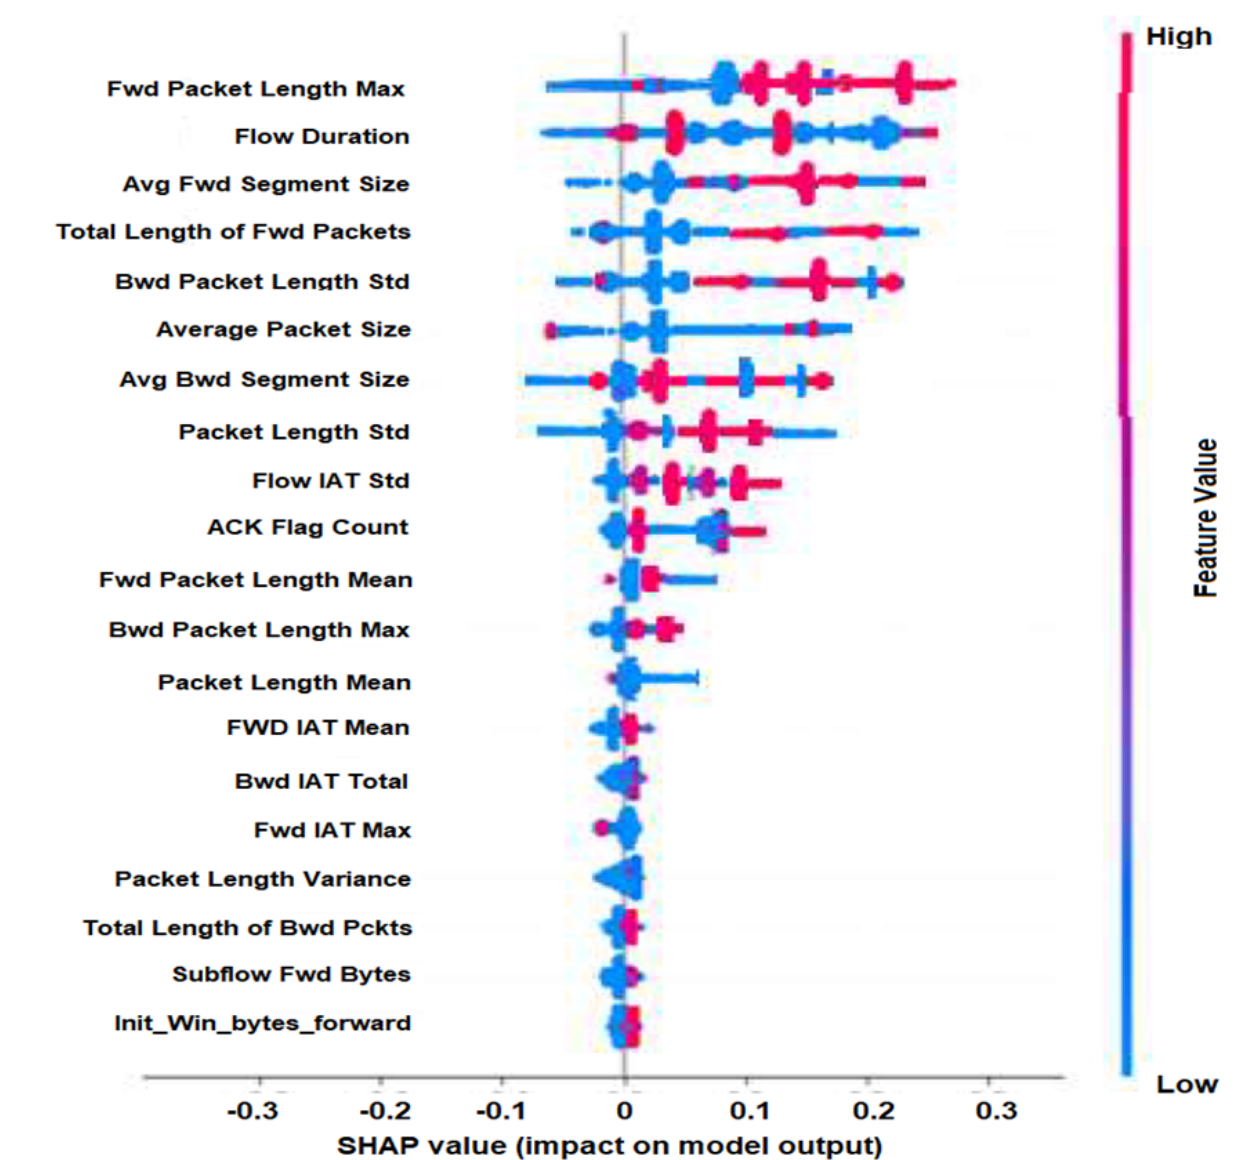
Figure 2. Summary plot with feature impact using SHAP. Red indicates a high-impact attack feature, while blue indicates a low-impact attack